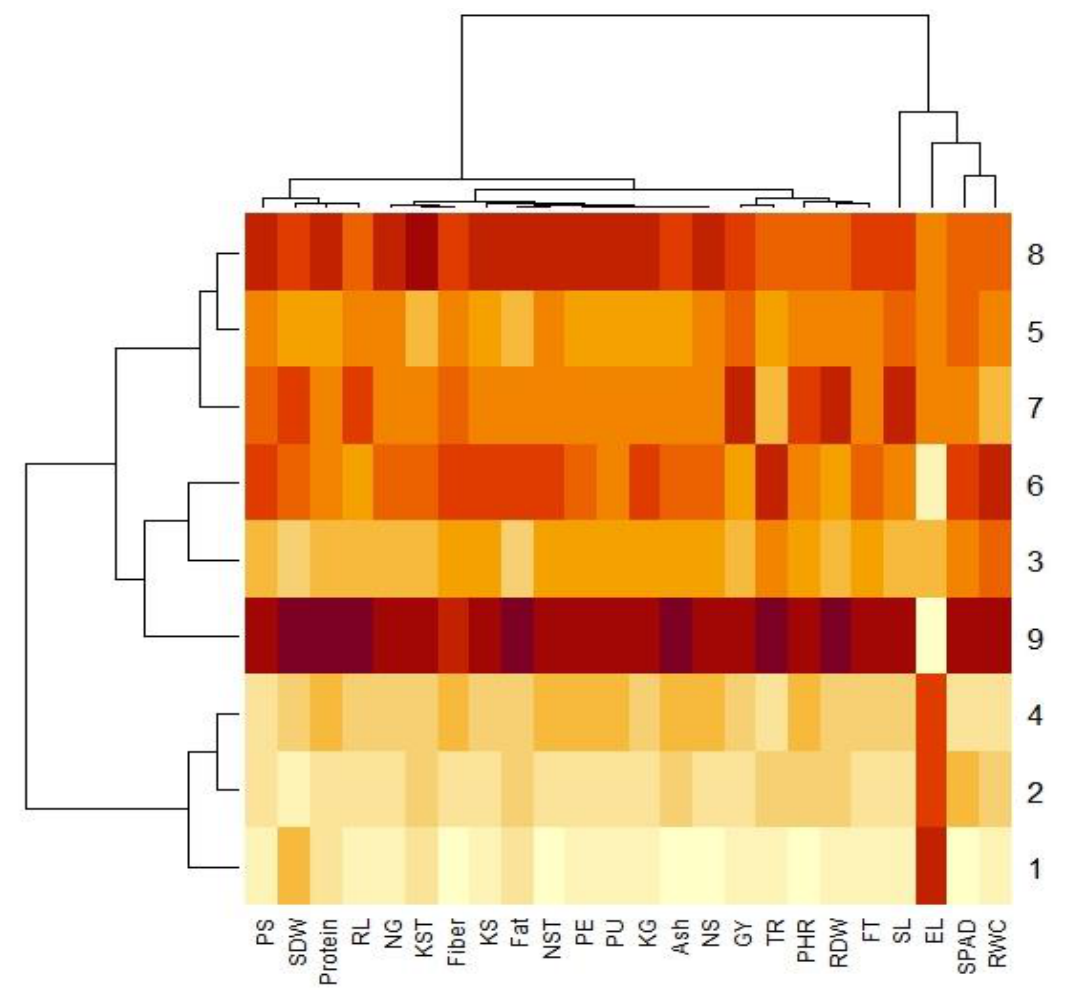
Figure 8. Heat map analysis based on the correlation of the observed variables under applied fermented and non-fermented manures with different levels of phosphorous. Colour intensity reflects level of significance among different treatments.